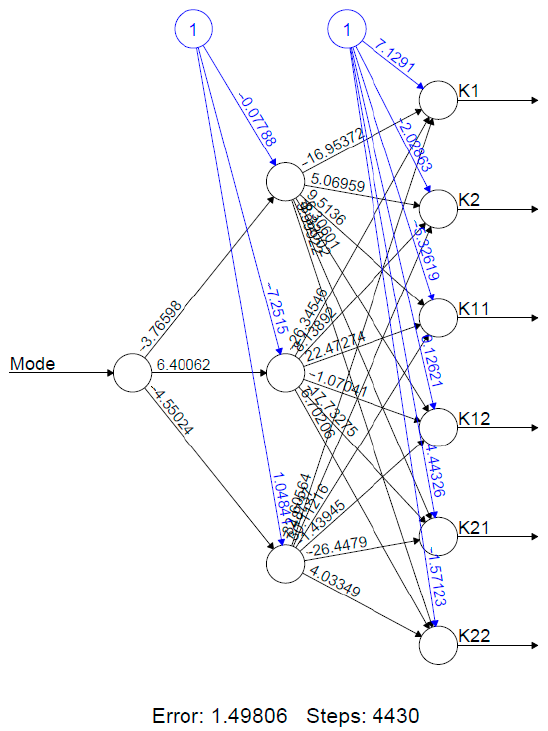
Figure 7. Nonlinear controller based on the SIMO-approximator.